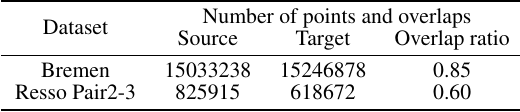
Table 1. Information of experimental datasets.